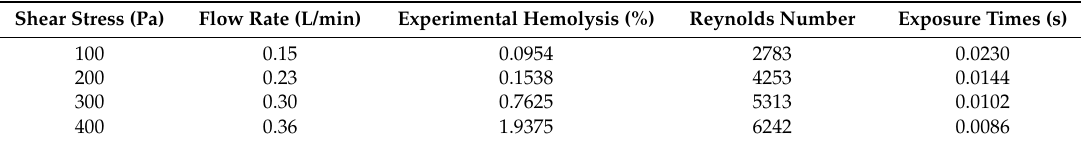
Table 2. Model conditions for capillary tube experiments